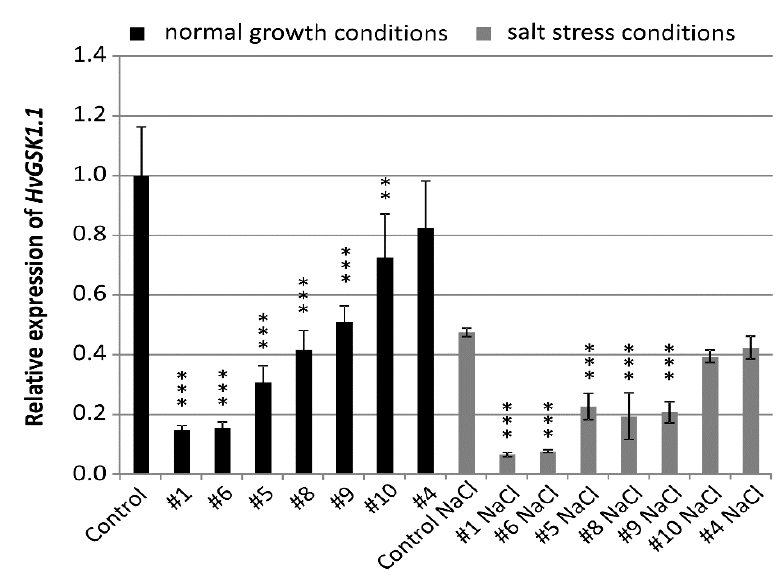
Figure 1. Relative expression of HvGSK1.1 (HORVU3Hr1G034440.2) in leaves of T 4 plants grown in normal (Hoagland medium) and in salt stress conditions (Hoagland medium supplemented with NaCl 200 mM). Relative expression of HvGSK1.1 in leaves of the non-transgenic control plants grown in normal conditions was assumed as 1.0. The ADP-ribosylation factor (ARF) AJ508228 was used as the reference gene. Data represent mean values and standard deviation of at least three biological replicates with three technical repetitions. Indicated are significant differences between the control and the line grown in the same conditions: ** p < 0.01, *** p < 0.001.